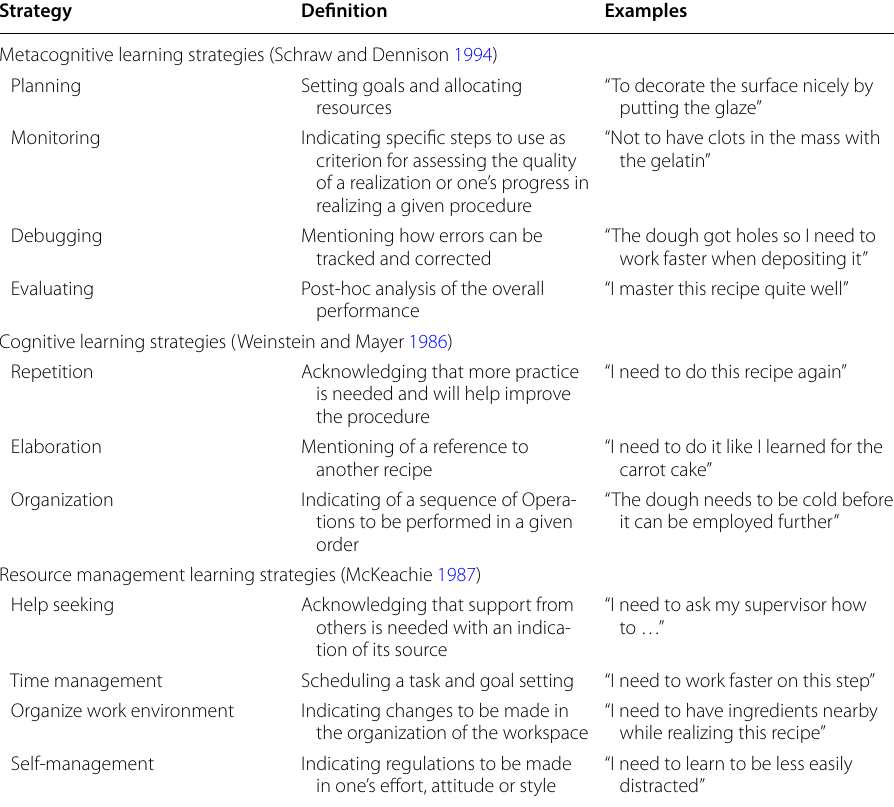
Table 1 Coding scheme for learner’s learning journal entries (final version after intercoder